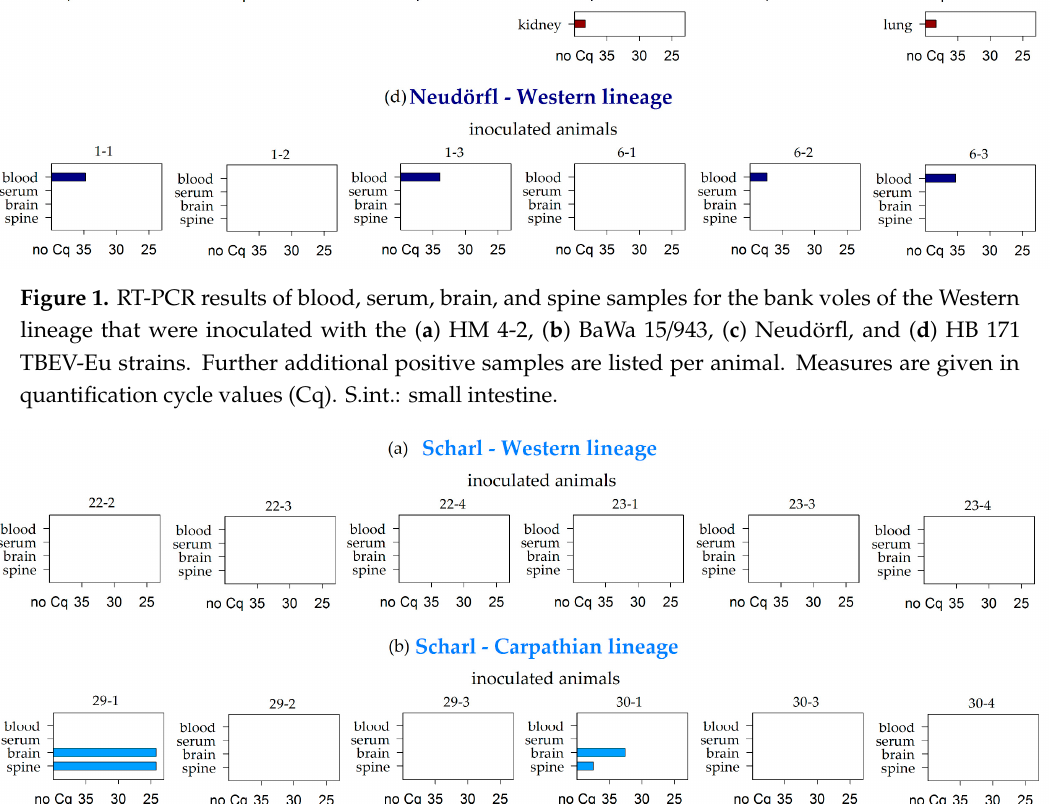
Figure 2. RT-PCR results of blood, serum, brain, and spine samples for the bank voles of the Western ( a ) and Carparthian ( b ) lineages that were inoculated with the Scharl TBEV-Eu strain. Measures are given in quantification cycle values